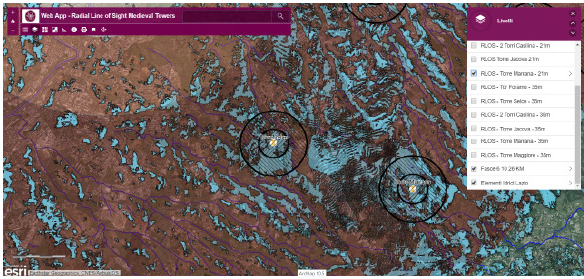
Figure 10. 2D Web App on ArcGIS Online